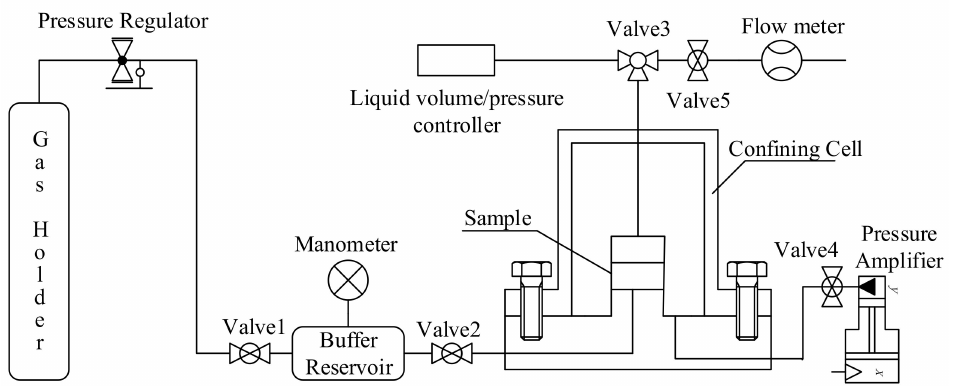
Figure 1. Schematic diagram of the gas permeability test